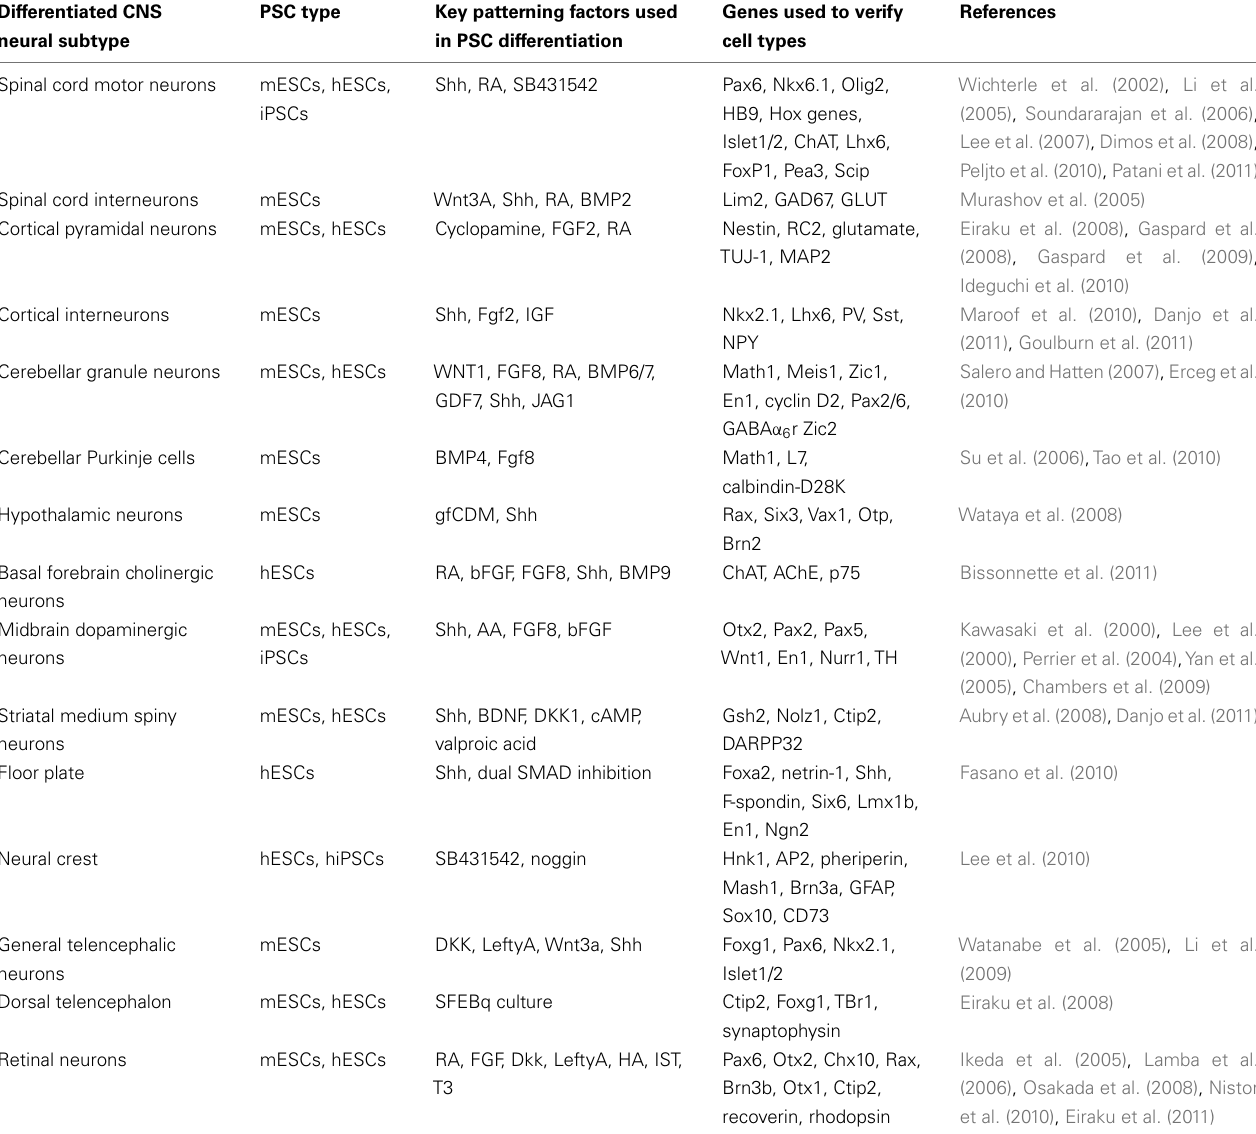
Table 1 |Table details the many different neural cells that have been derived from PSCs to date, specifying the type of PSC, the key exogenous signaling factors, the markers used to verify cell type specificity, and the corresponding